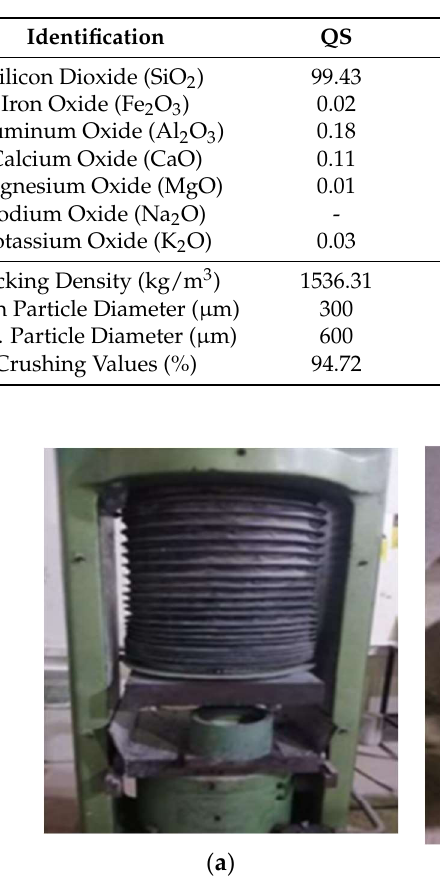
Table 1. Properties and Composition of the Materials Used.